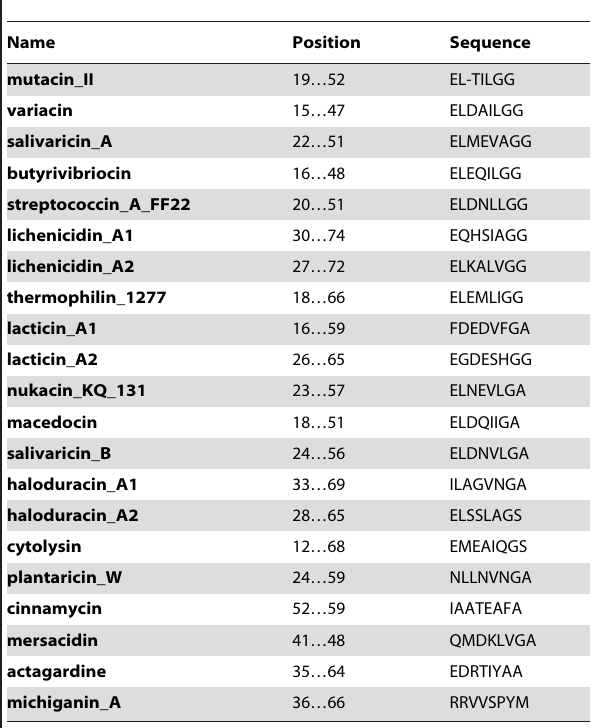
Table 2. Class I cleavage site motif sequences. Table 3. Class II cleavage site motif